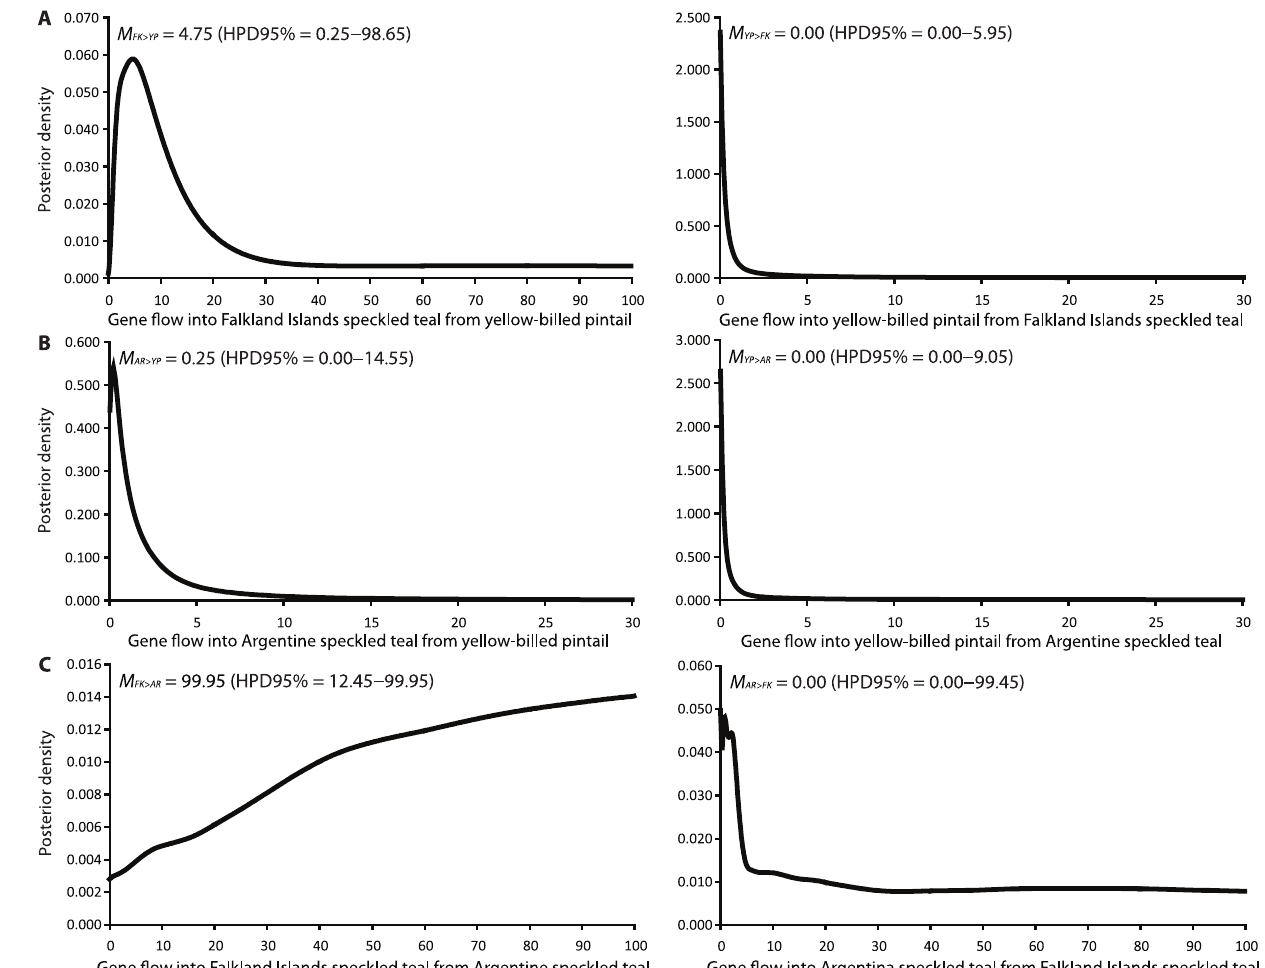
Figure 4. Gene flow ( M = m / m ) estimates from the IMa2 analysis of six nuclear loci.